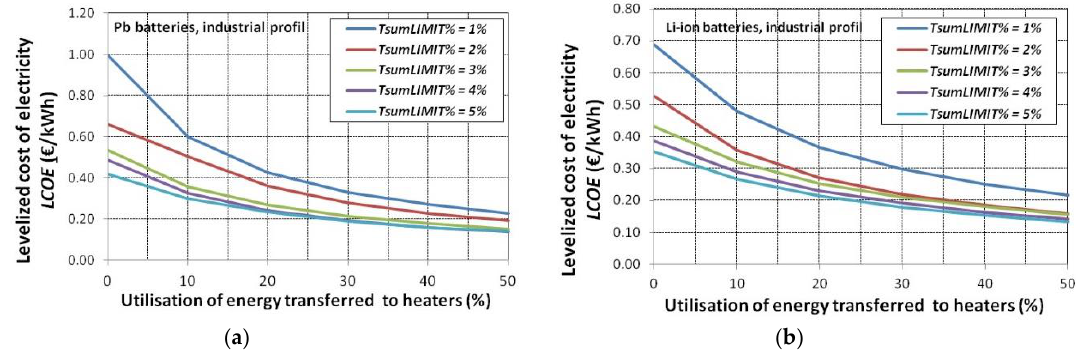
Figure 15. A change in the LCOE for optimum systems in the function of maximum time T sumLIMIT% and cases of the percentage use of energy emitted on the heaters during technological processes (industrial profile, 50 kW peak power load): ( a ) lead-acid batteries, ( b ) lithium-ion batteries.